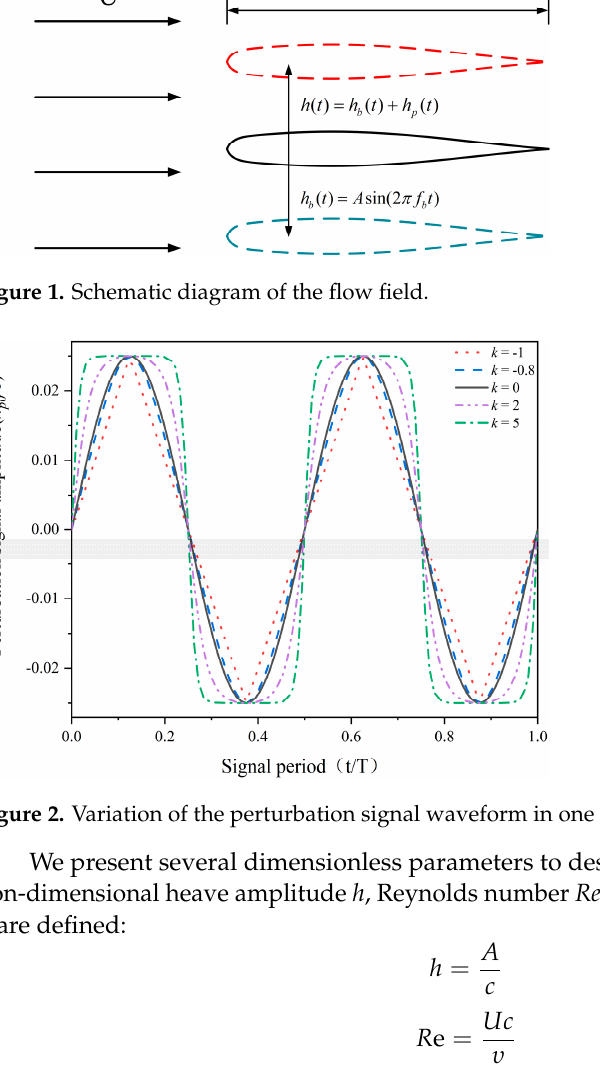
Figure 1. Schematic diagram of the flow field.